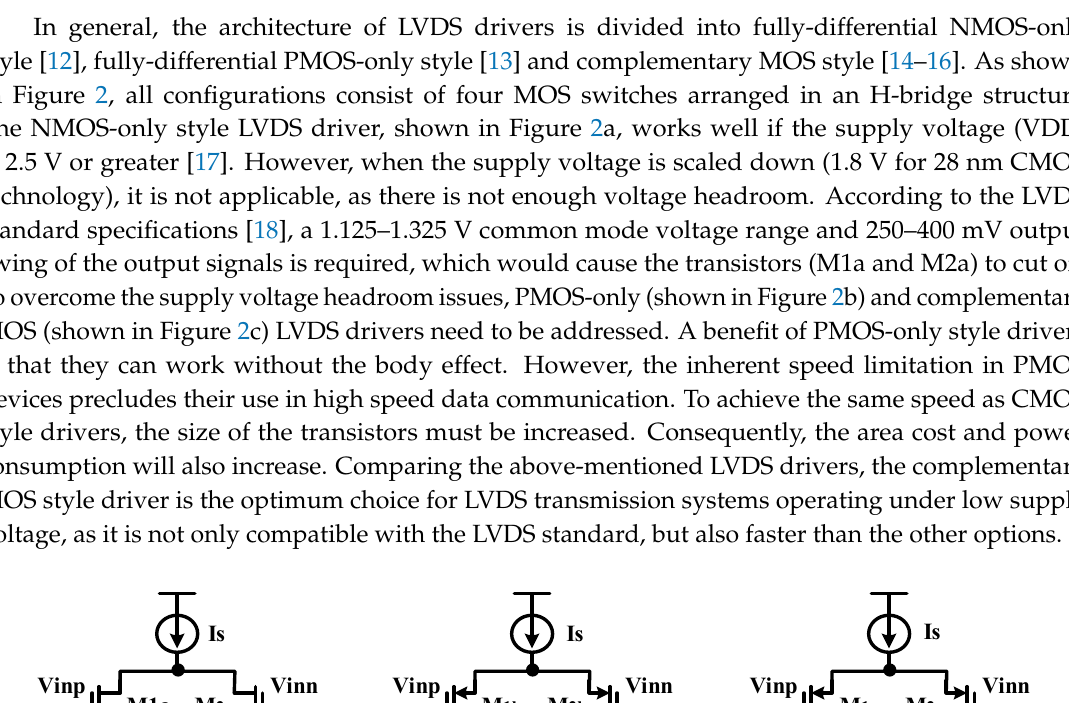
Figure 1. Low voltage differential signaling (LVDS) serial link communication block.